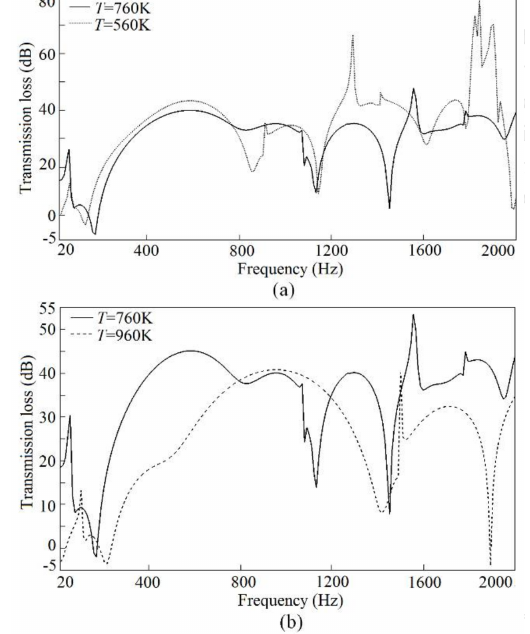
Figure 15. Effects of temperature on the TL of the silencer ( v = 55 m/s) : ( a ) 760 K versus 560 K; ( b ) 760 K versus 960